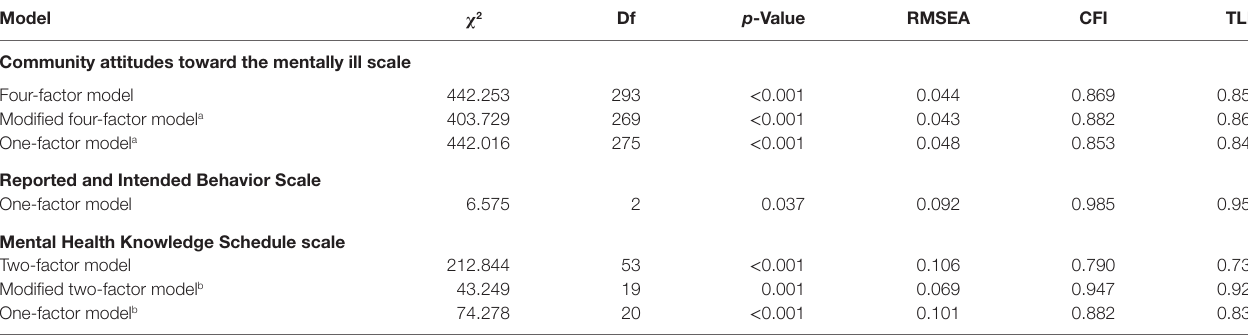
TaBle 1 | Comparisons of model fit for the three stigma scales ( N = 268). Model